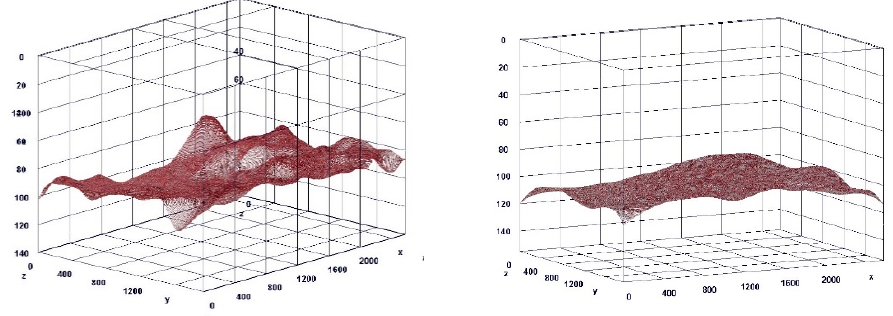
Figure 13. Visualization of the differences in elastin concentration before and after treatment.